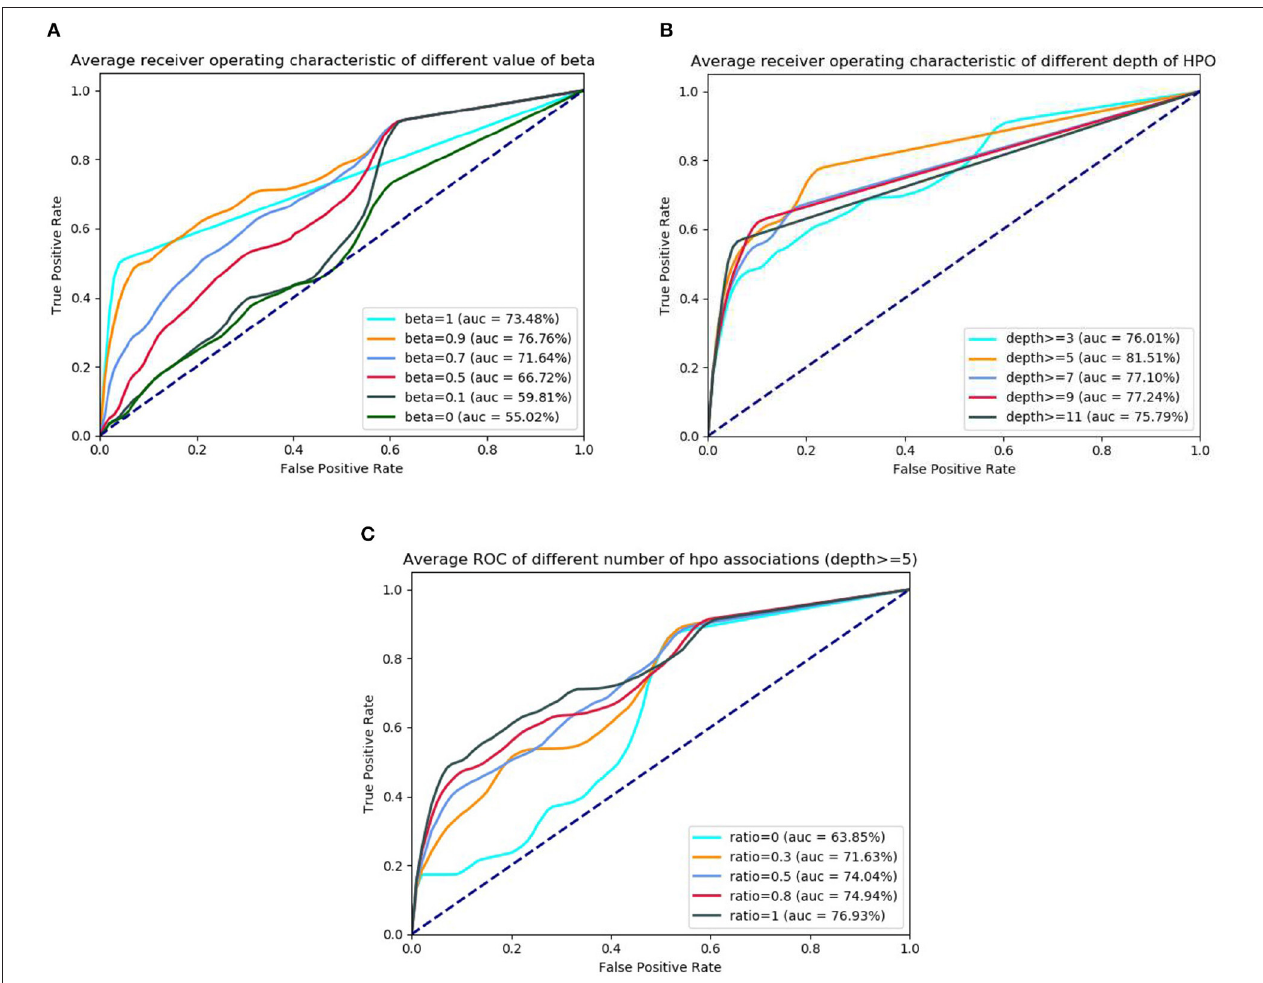
FIGURE 4 | The ROC and AUC using different phenotypic factors. (A) ROC of different beta. (B) ROC of different HPO’s depth. (C) ROC of different HPO’s quantity.